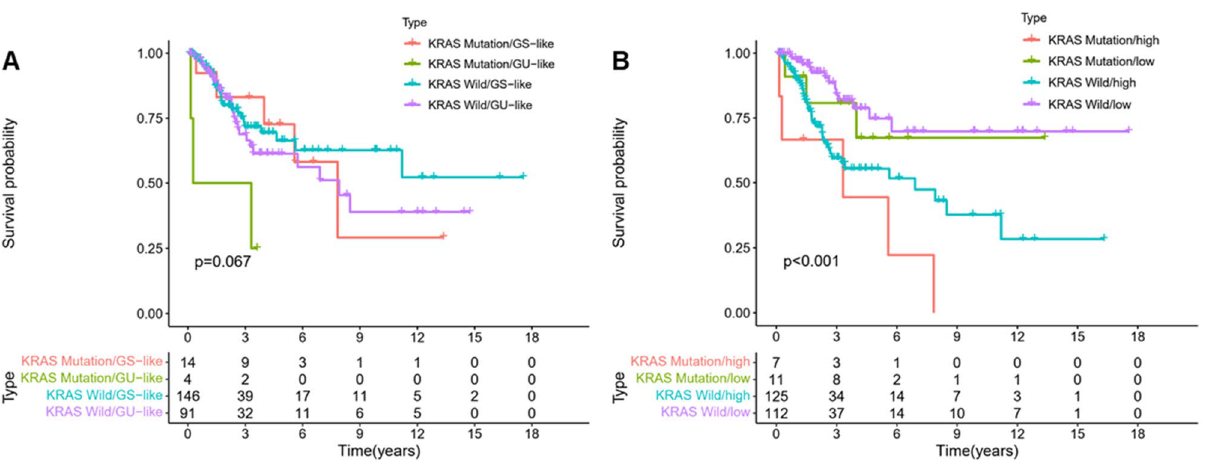
Figure 6. Combined survival analysis of genotyping and mutation. ( A ) Kaplan–Meier curve analysis of overall survival is shown for patients classified according to KRAS mutation status and the GU/GS. ( B ) Kaplan–Meier curve analysis of overall survival is shown for patients classified according to KRAS mutation status and the